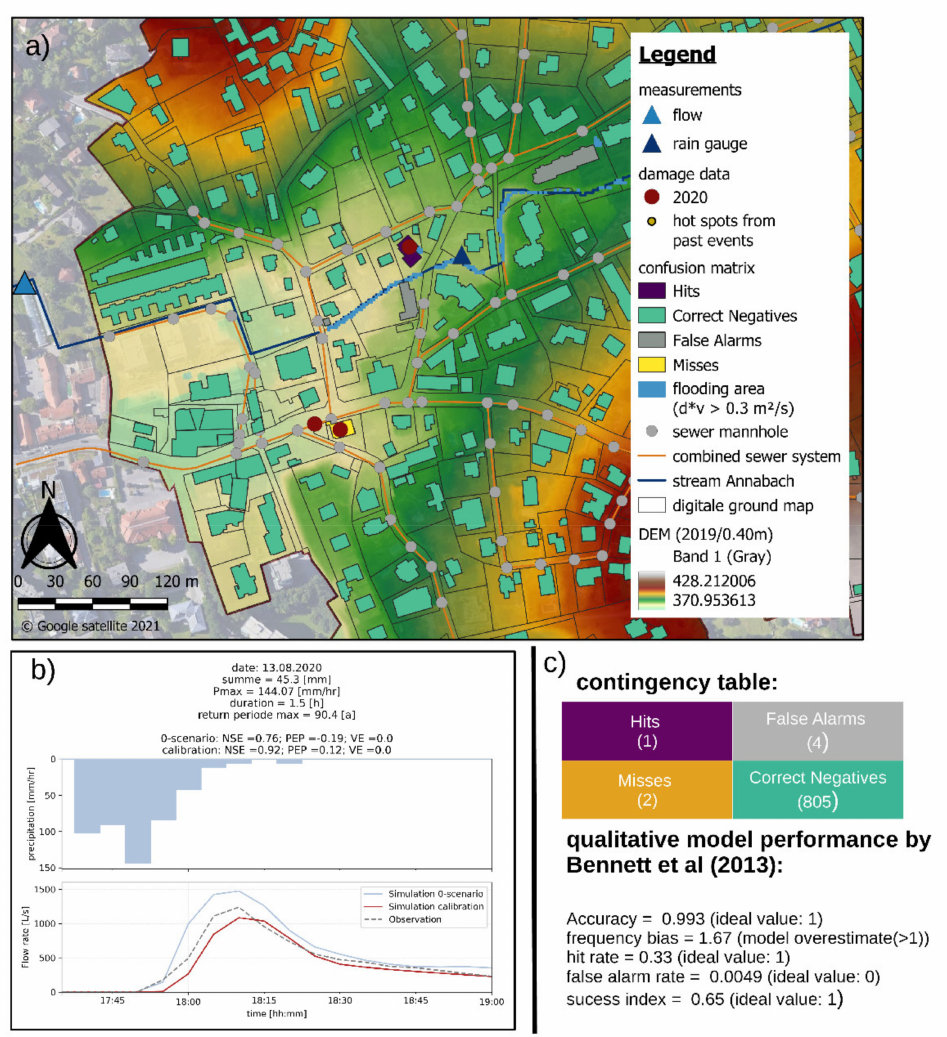
Figure 7. Model calibration and validation with the real heavy storm event on 13 August 2020: validation of the spatial distribution of the urban flooding process with the recorded damage data and flooding area ( a ); consideration of the temporal distribution of urban flooding with the surface flow comparison in the Annabach stream on the end of the study site ( b ); resulting contingency table and the performance indicators ( c